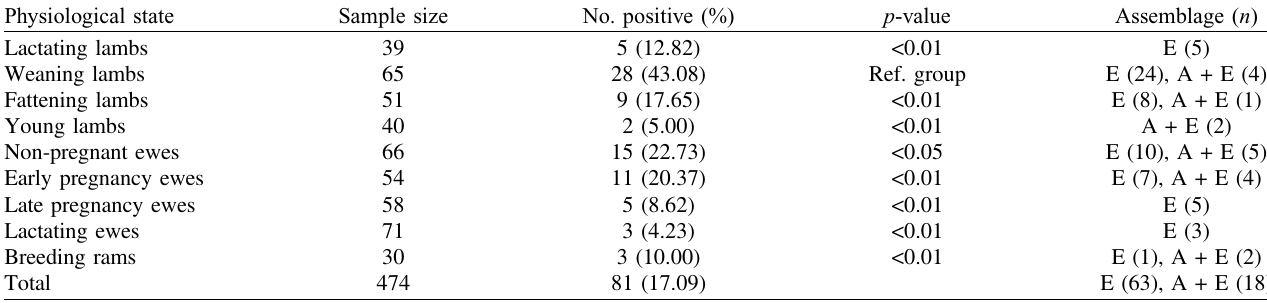
Table 2. Prevalence of G. duodenalis in Hu sheep of different physiological stages.